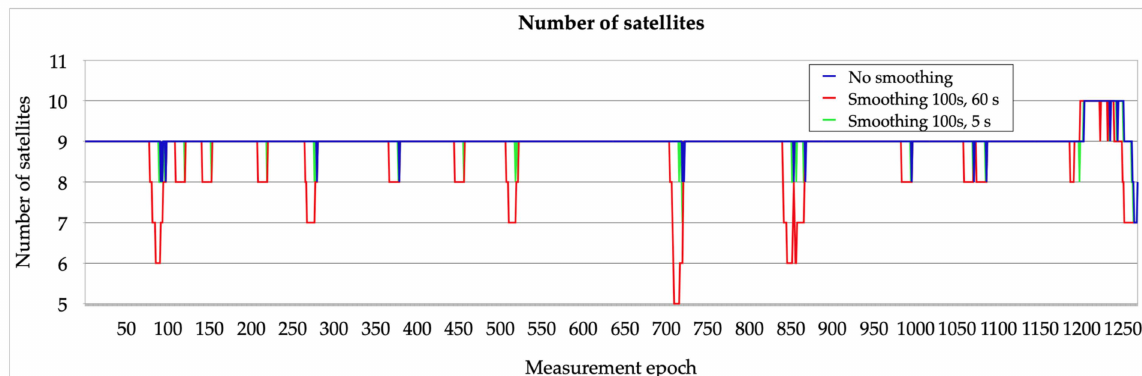
Figure 2. Number of satellites used in positioning in the no smoothing, smoothing 100 s, 5 s, and smoothing 100 s, 60 s